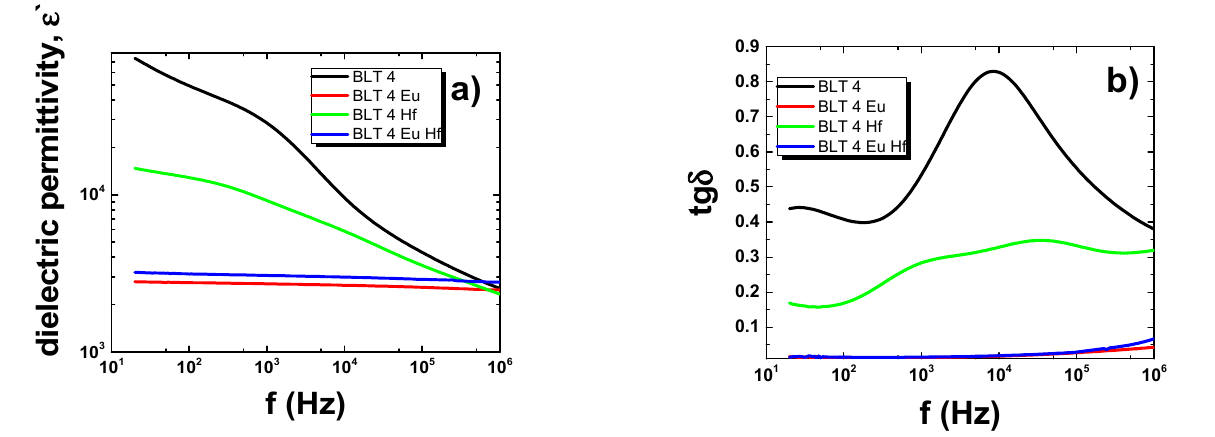
Figure 2. Frequency dependences of dielectric permittivity ( a ) and loss factor ( b ) measured for pure BLT4 ceramics and doped with 0.4% mol. europium, 0.4% mol. hafnium, and simultaneously 0.4% mol. europium and 0.4% mol. hafnium, at room temperature.